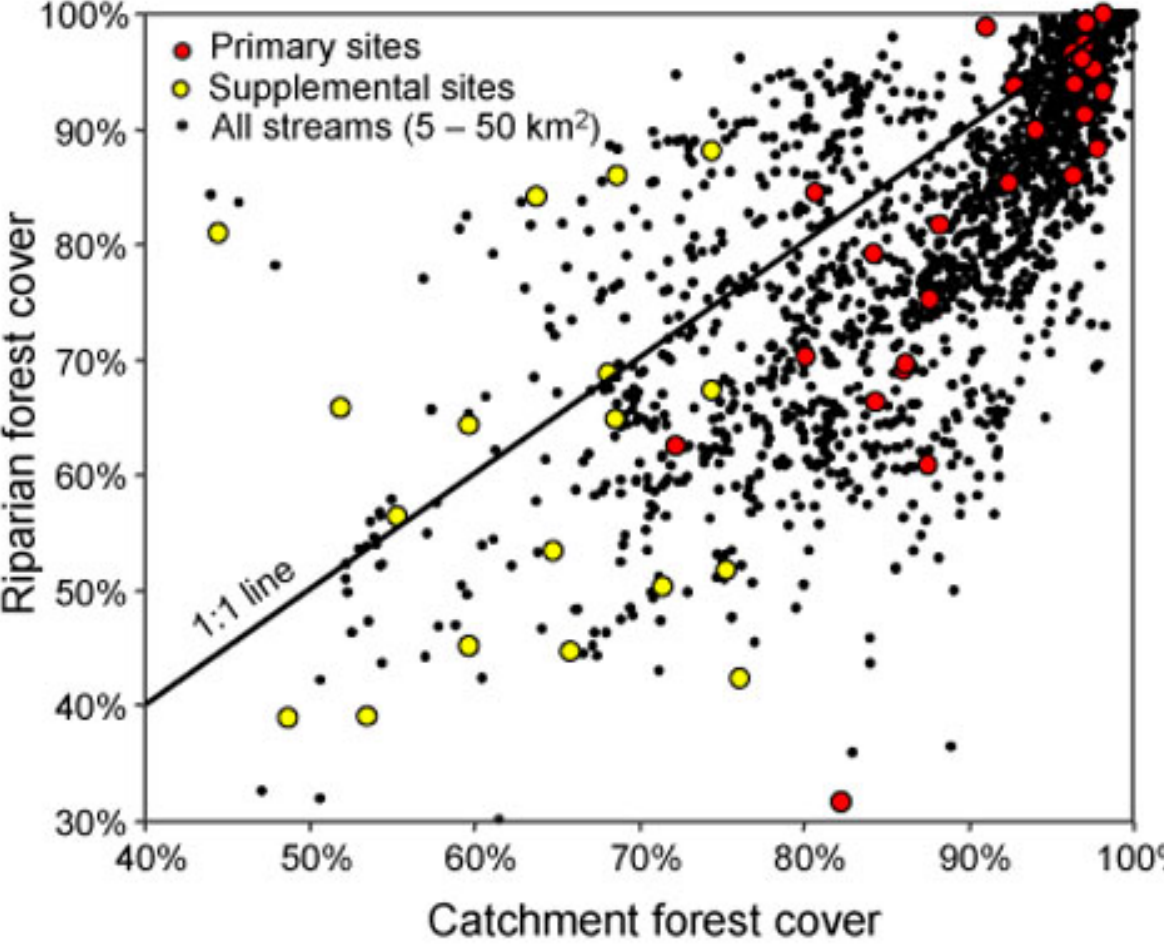
Fig. 7. Percent riparian forest cover vs. percent catchment forest cover for the pool of 4019 potential sampling sites (see text). The primary data set (red dots) were 3 rd order or larger streams, and are representative of basin area, elevation, and riparian forest cover conditions across the trout stream network (Fig. 5). The supplemental data set (yellow dots) were specifically chosen to have uncorrelated percent riparian and catchment forest cover values ( p =